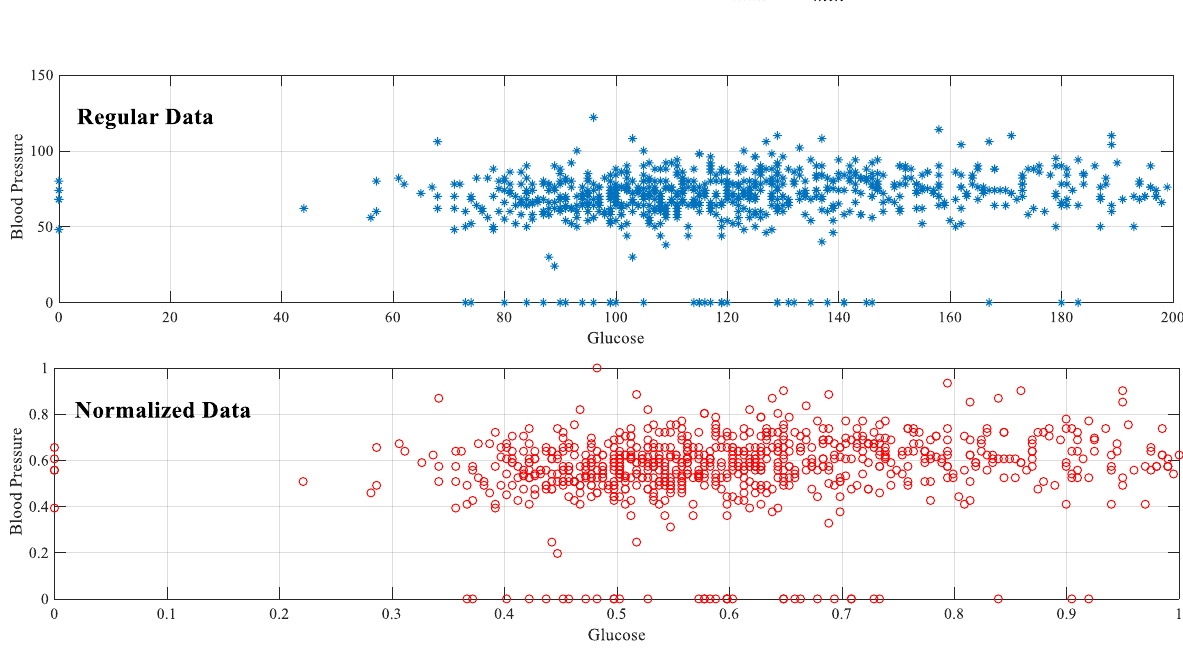
Figure 3. Min – max normalization of PIMA dataset.